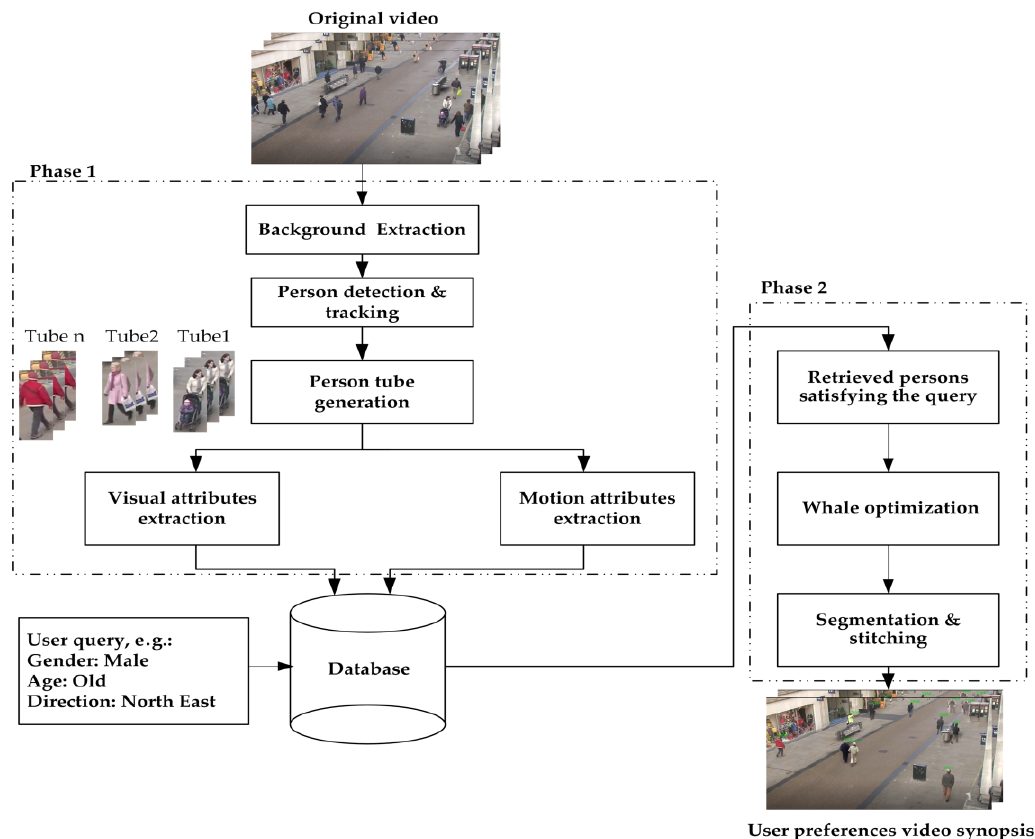
Figure 2. Proposed system